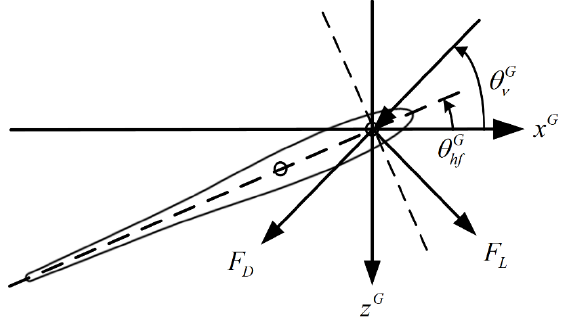
Figure 3. The vectors of drag force, lift force and flow velocity.